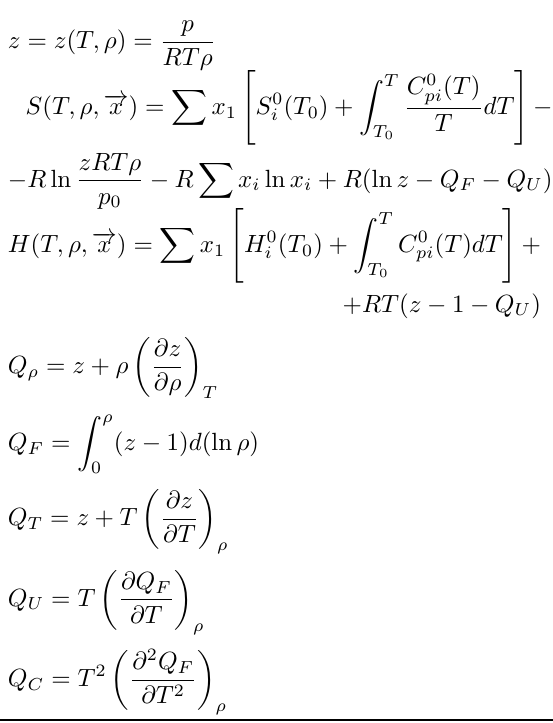
Table 5. Relations for calculation of entropy and enthalpy of real gas and relations for calculation of dimensionless quantities Q